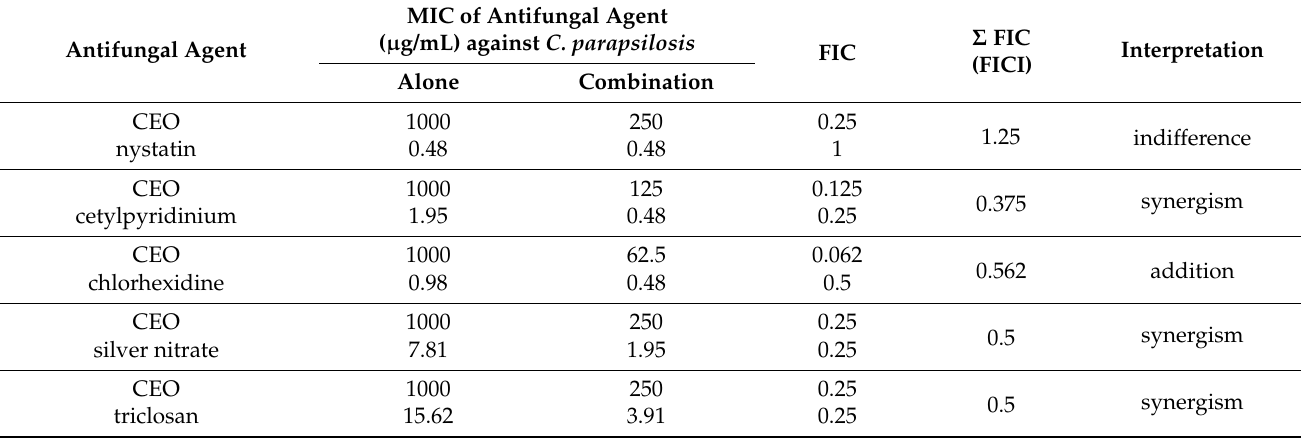
Table 8. MICs and FIC indices of CEO alone and in combination with selected antimycotics on reference C . parapsilosis ATCC 22019 strain.